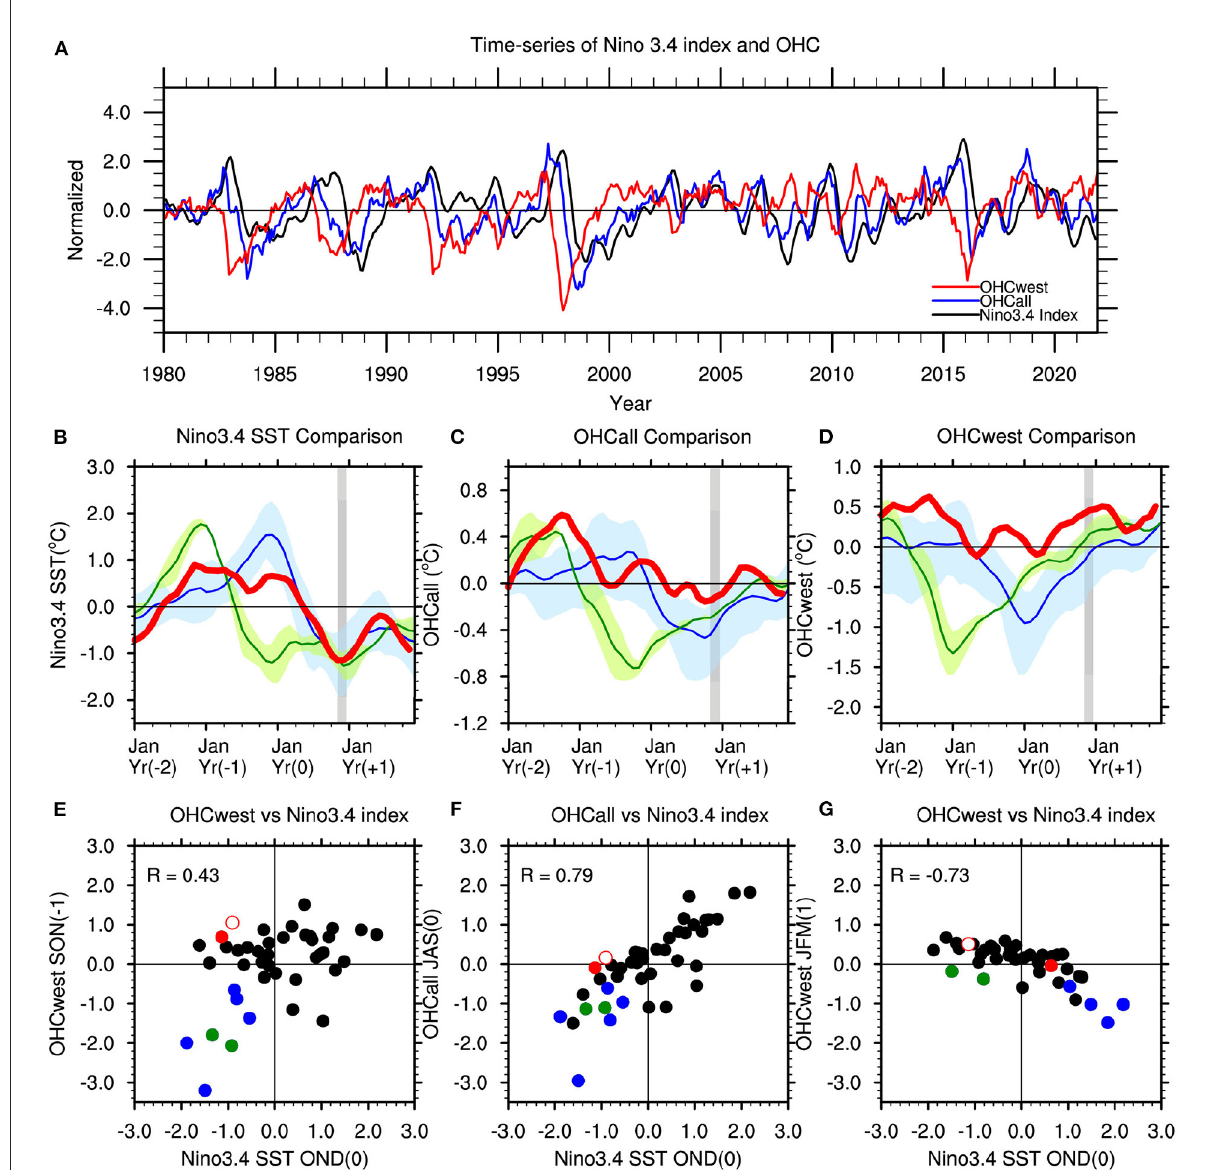
FIGURE1 (A) Time-series of normalized Niño 3.4 index (black; 5 ◦ S–5 ◦ N,120 ◦ –170 ◦ W), OHCall (blue; 5 ◦ S–5 ◦ N, 120 ◦ E–80 ◦ W), and OHCwest indices (red; 5 ◦ S–5 ◦ N, 120 ◦ E–155 ◦ W). A 3 − month running mean filter is applied to these indices. Time-series of (B) Niño 3.4 SST (C) OHCall and (D) OHCwest of 2020–2022 La Niña event (red) compared with typical La Nina events (blue: 1983/84, 1988/89, 1995/96, 1998/99, 2016/17, and green: 1984/85, 1999/00) following a large El Niño. Scatterplots of the Niño 3.4 index in OND(0) with (E) the OHCwest in SON(-1), (F) the OHC all in JAS(0), and (G) the OHCwest in JFM(1). The blue and green dots represent the typical La Niña years (1983/84, 1988/89, 1995/96, 1998/99, 2016/17, and 1984/85, 1999/00) and the filled red and hollow red dots represent the 2020/21 and 2021/22 case,